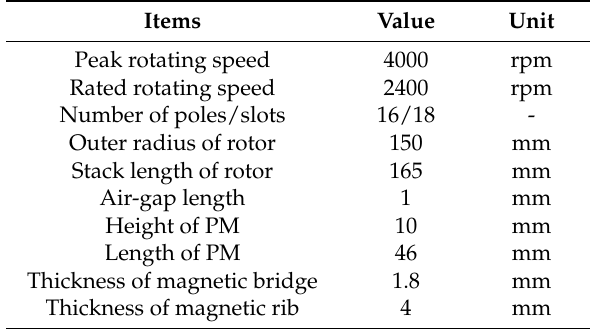
Figure 1. Cross-sectional view of the PMSIWM with IPM rotor. Table 1. Main parameters of interior permanent magnet synchronous motors